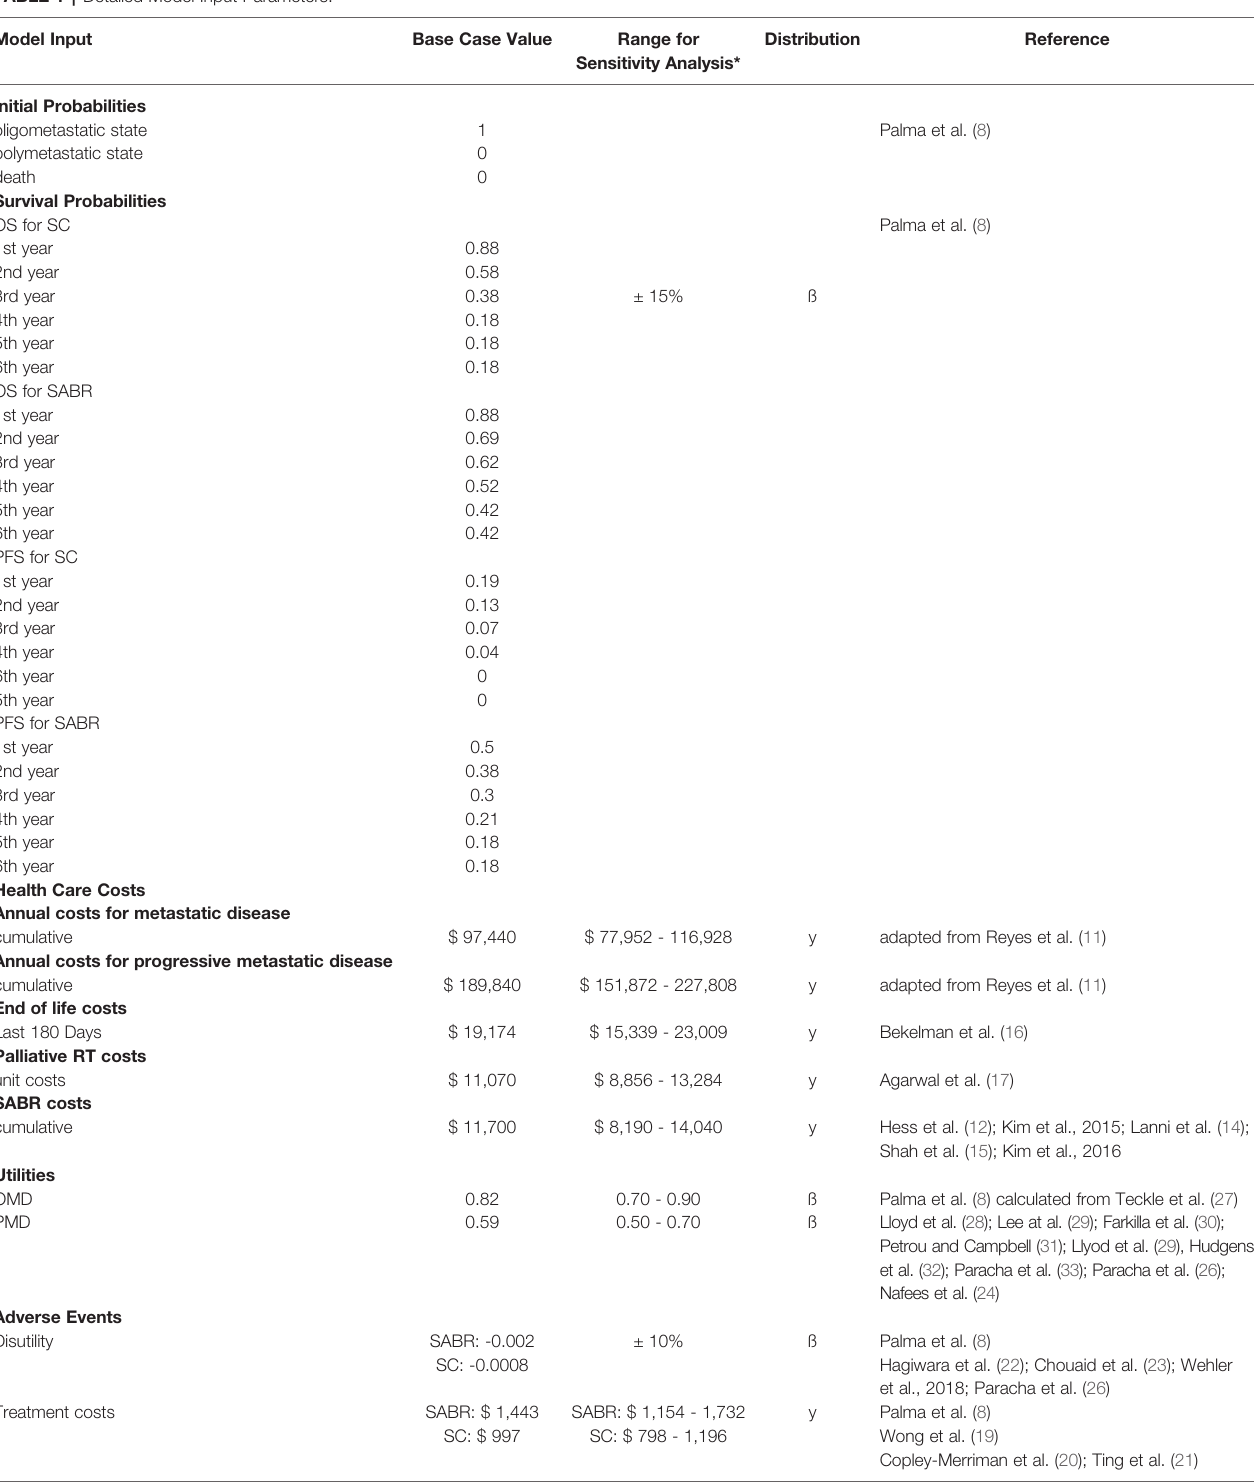
TABLE 1 | Detailed Model Input